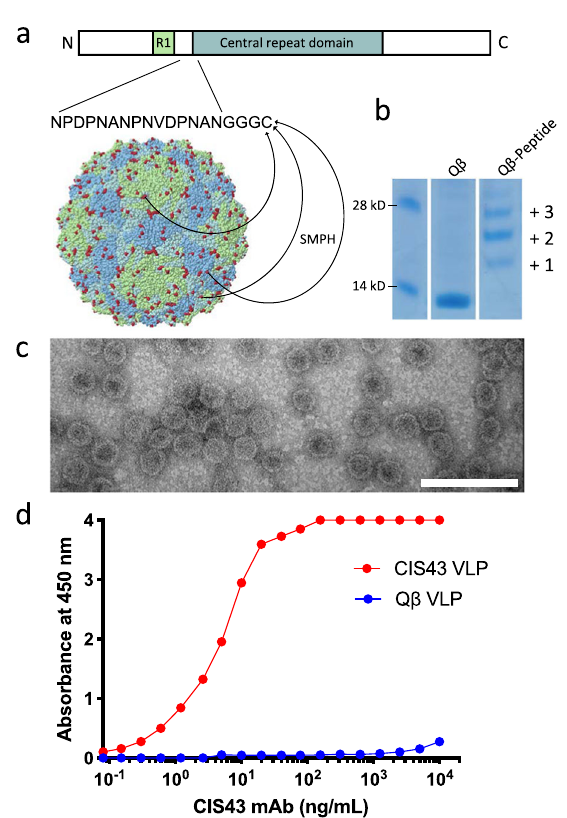
Fig. 1 Characterization of CIS43 VLPs. a Schematic representation of CSP showing the location of the CIS43 epitope and the process of CIS43 VLP conjugation. A 15-amino acid peptide representing the CIS43 mAb epitope was synthesized to include a (Glycine) 3 -Cysteine linker and conjugated to surface-exposed lysine residues (shown in red) on the coat protein of Q β bacteriophage VLPs using the bifunctional crosslinker SMPH. b SDS-PAGE analysis of unconjugated (center lane) or CIS43 peptide conjugated (right lane) Q β VLPs. The ladder of bands in the CIS43 VLP lane re fl ect individual copies of coat protein modi fi ed with 1, 2, or more copies of the CIS43 peptide. Gel images are derived from the same experiment and were processed in parallel. Size markers are shown in the left lane. The unmodi fi ed gel is shown in Supplementary Fig. 2. c Transmission electron micrograph of the CIS43 VLPs. VLPs are visualized at a magni fi cation of 200,000x. Scale bar (in white) represents 100 nm. d Binding of the CIS43 mAb to CIS43 VLPs (red) or wild-type (unmodi fi ed) Q β VLPs (blue) as measured by